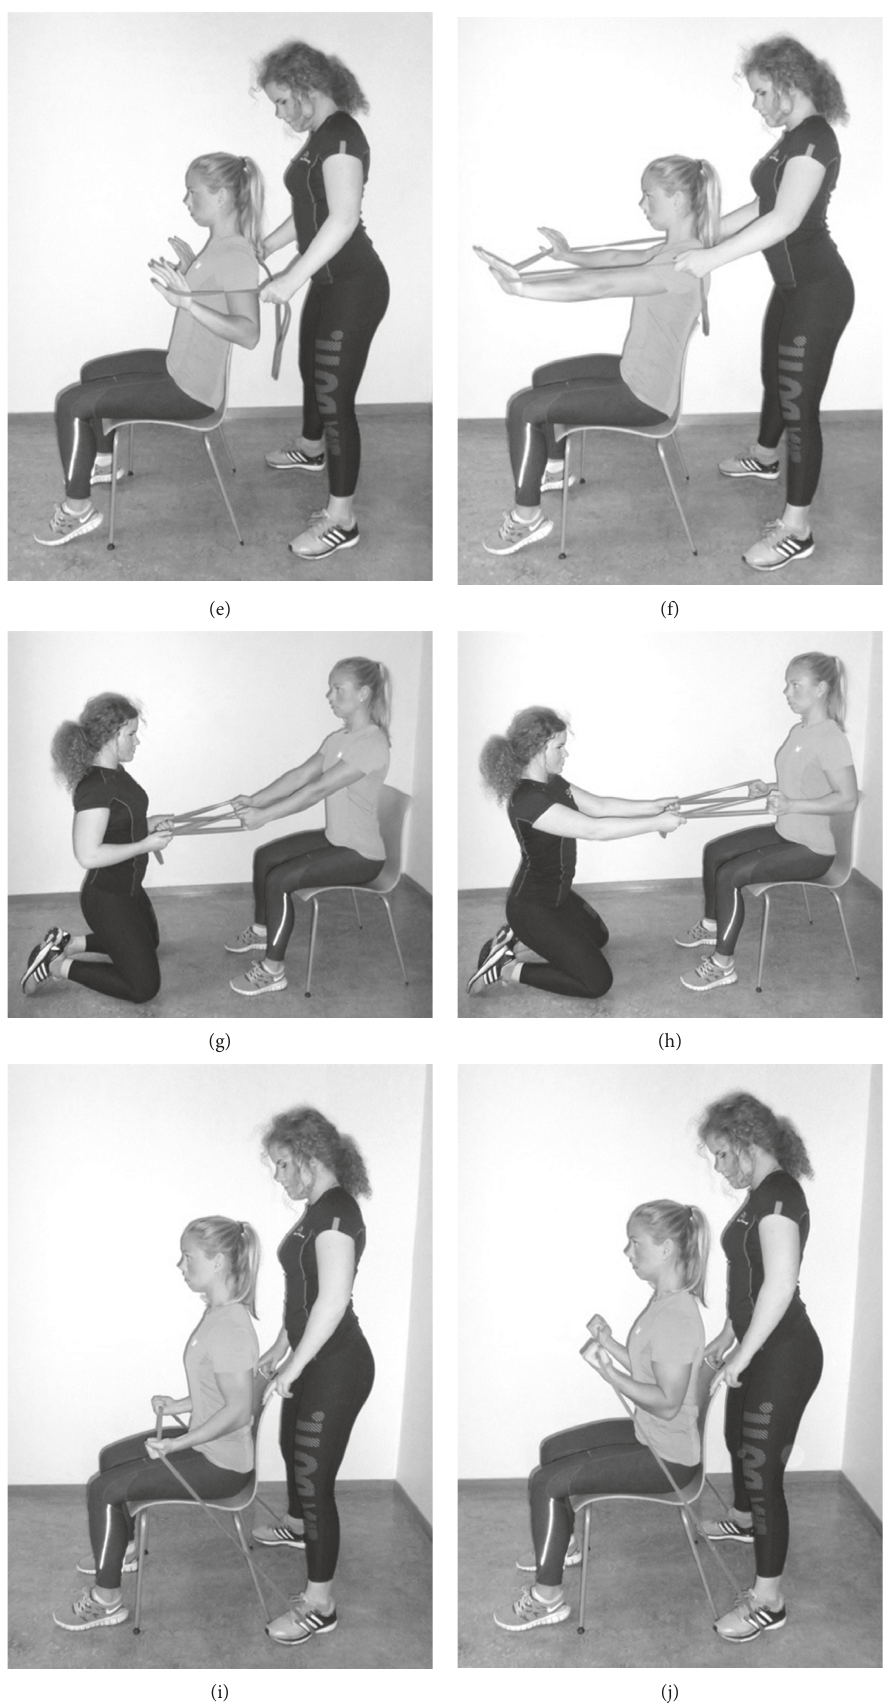
Figure 2: (a–j) An overview of the five training